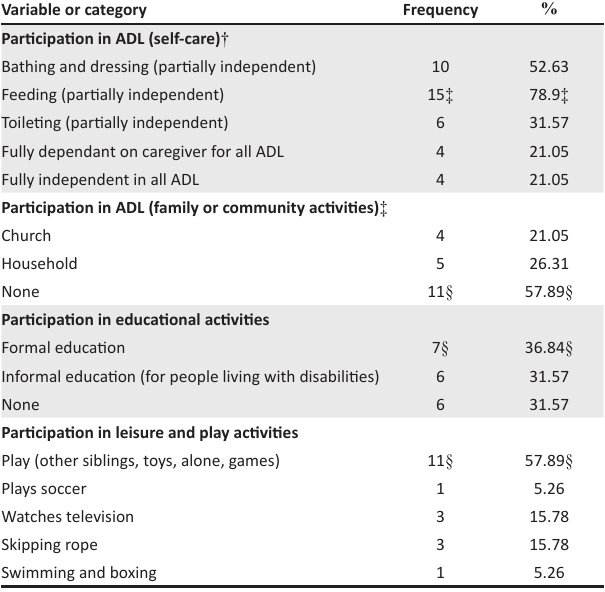
TABLE 2: Quantitative data on children’s participation patterns in activities of daily living, education, leisure and play ( N = 19). Variable or